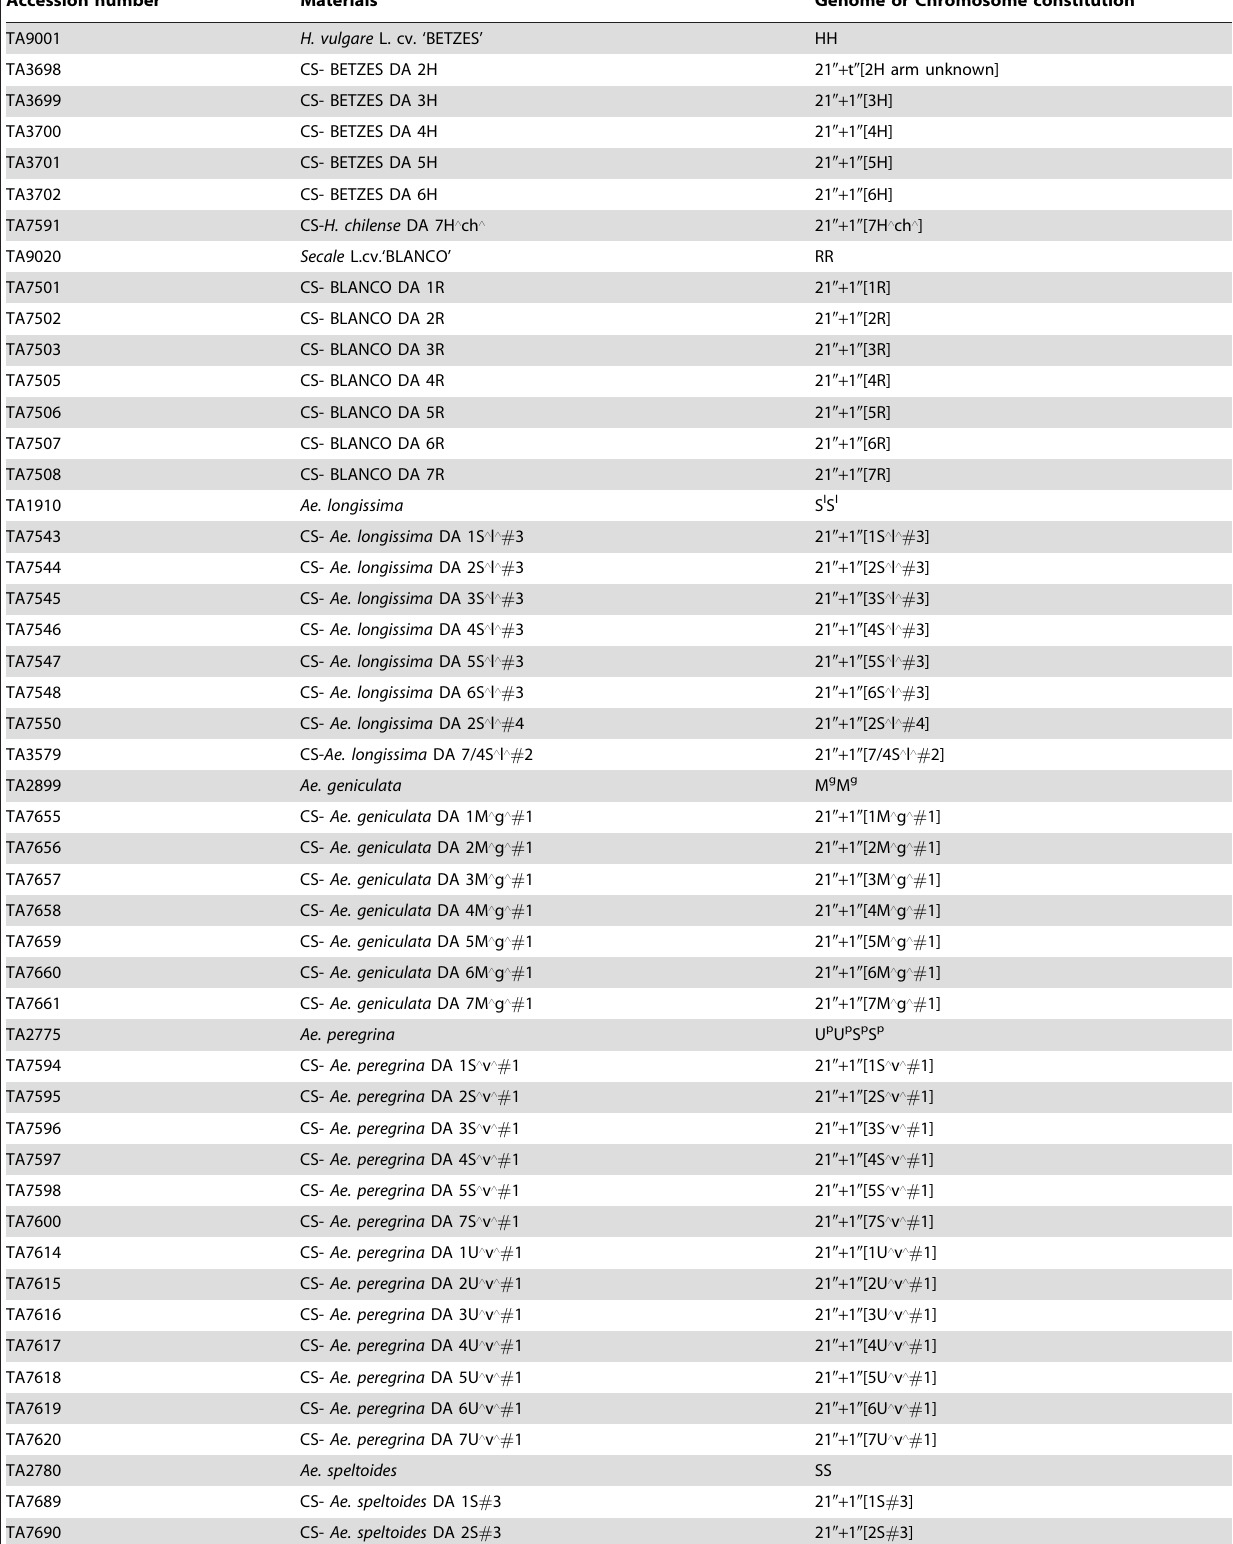
Table 1. Plant materials introduced from the WGGRC, KSU,